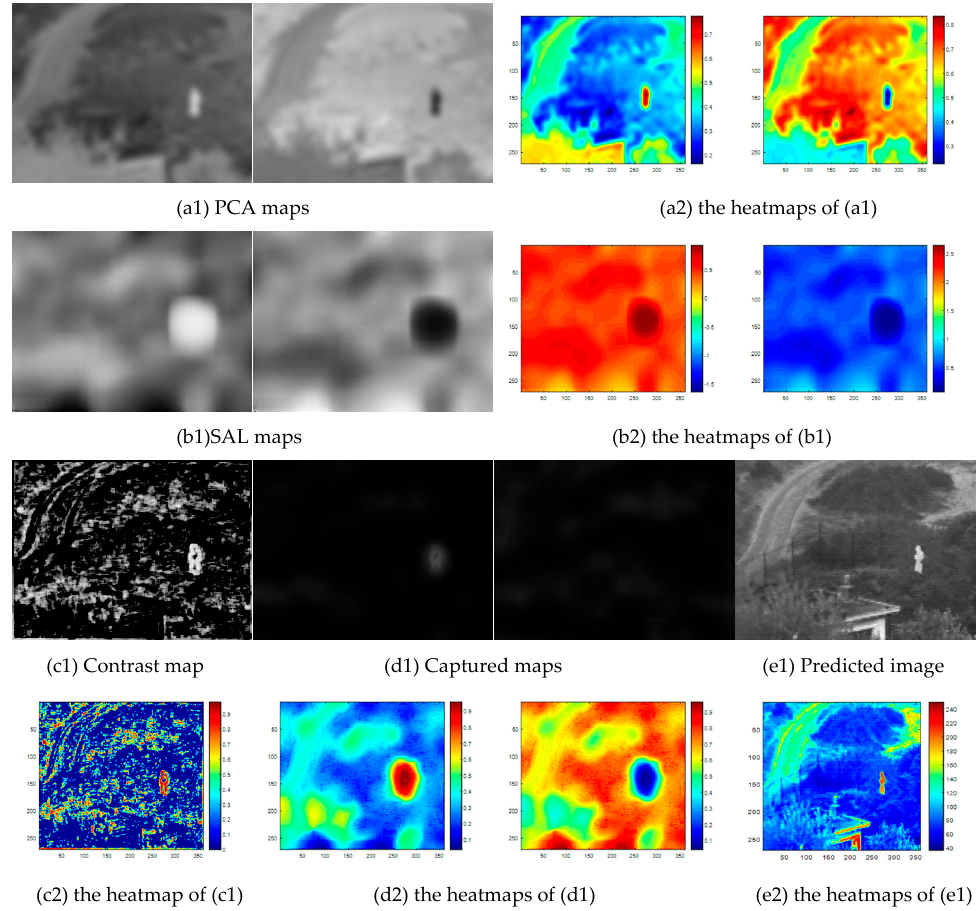
Figure 8. The visual maps and their corresponding heatmaps of SGCM in the fusion framework (Figure 1).